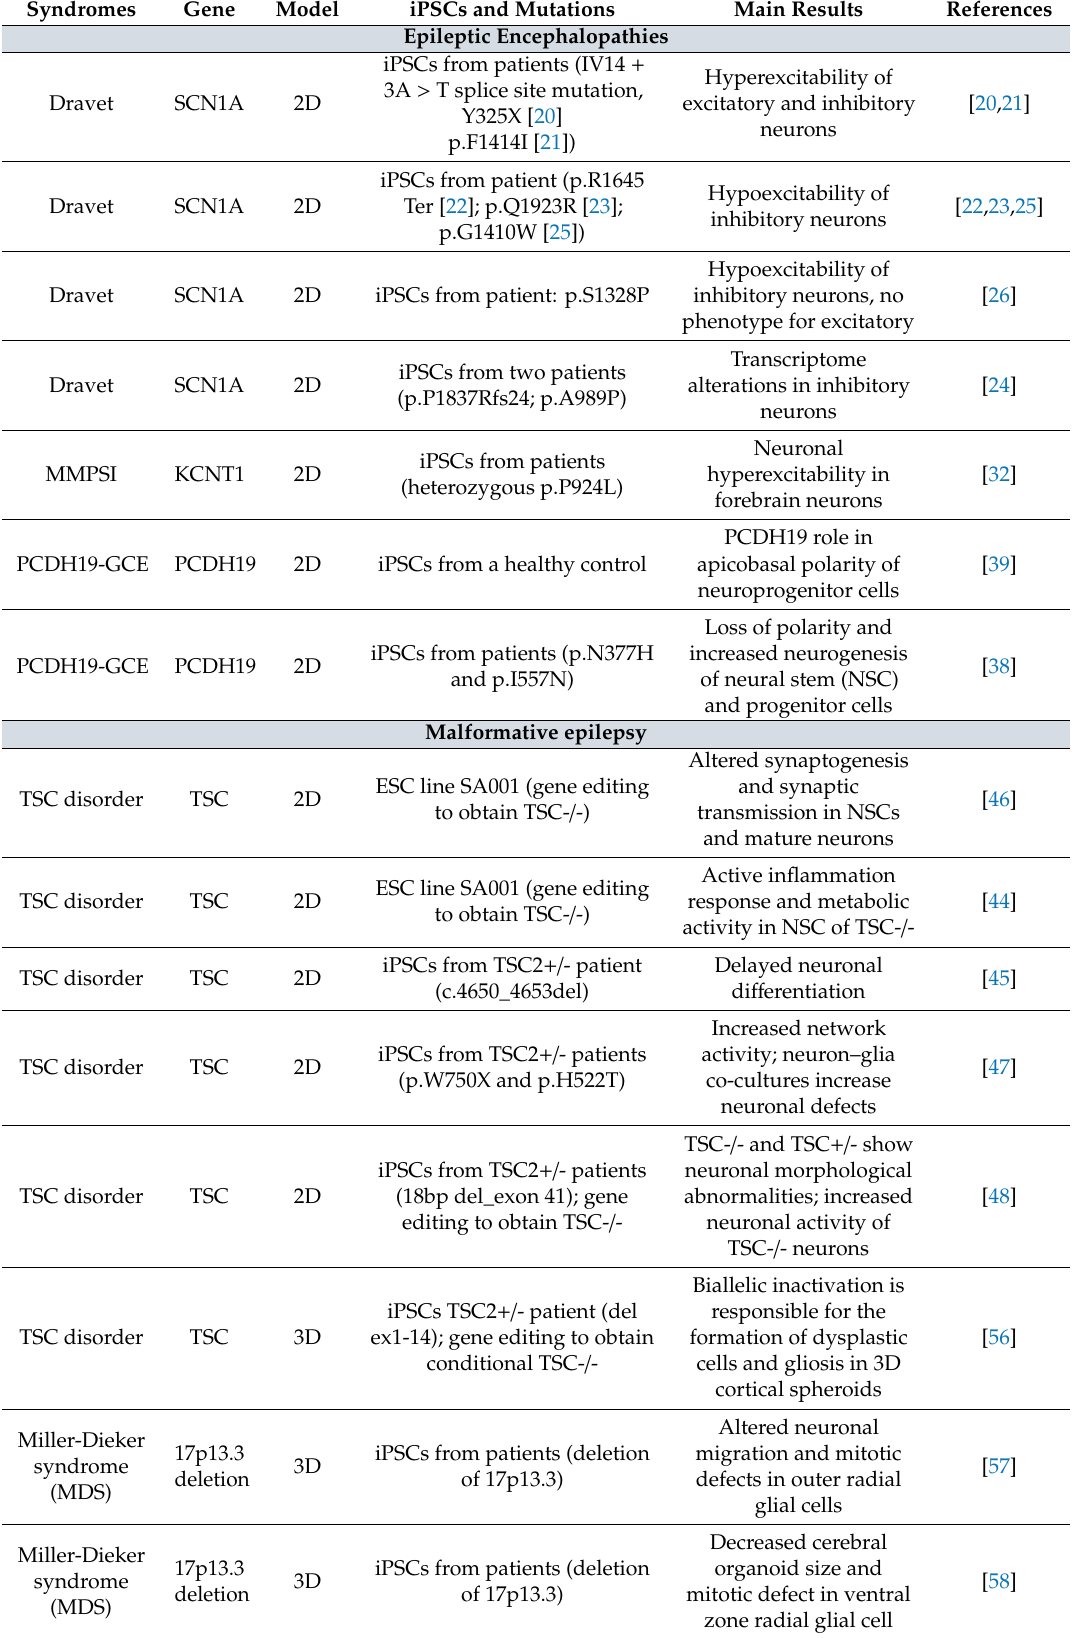
Table 1. Summary of iPSC-based models of